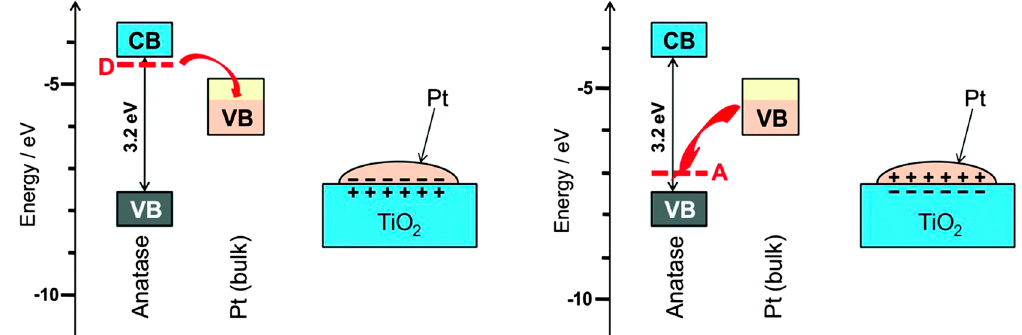
Figure 3. Schottky contacts in a Pt/TiO 2 (anastase), which can strongly affect the catalytic properties of a system ( right ). Additional charge-compensating electrons at the neighboring Ti atoms can occur as a result of the presence of an HO impurity in TiO 2 ( left ). Its location is below the conduction band (CB). The transfer of the donor state electrons to the partially filled valence band (VB) of the metal (Pt) creates a charge-polarized interface. © Adopted from [43,68].